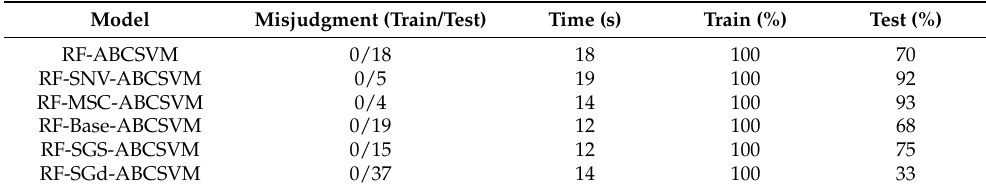
Table 6. The Ranman spectra after five different pretreatments are extracted using the random forest algorithm, and the ABC-SVM classification models are established using the extracted feature variables.